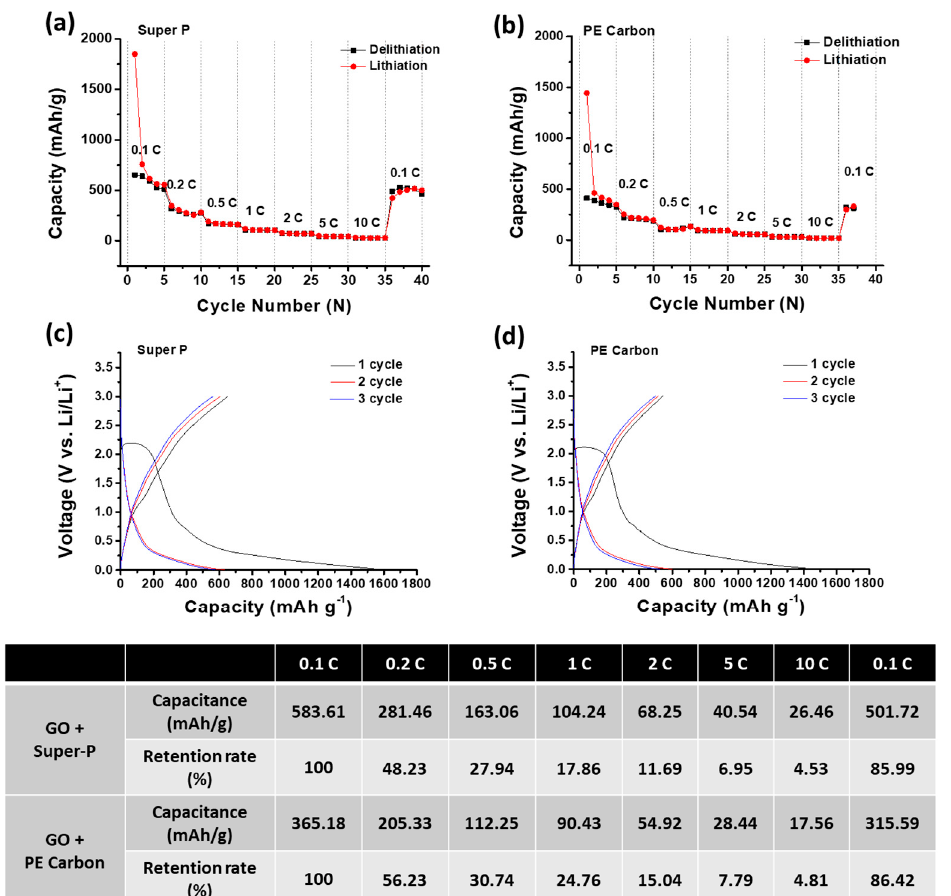
Figure 6. Cell performance of lithium-ion batteries (LIBs) assembled using Super-P and PE carbon as conductive agent. Capacity and the coulombic efficiency (CE) of LIBs from ( a ) Super-P and ( b ) PE carbon at 0.1–10 C-rate. Galvanostatic charge/discharge curves of LIBs from ( c ) Super-P and ( d ) PE